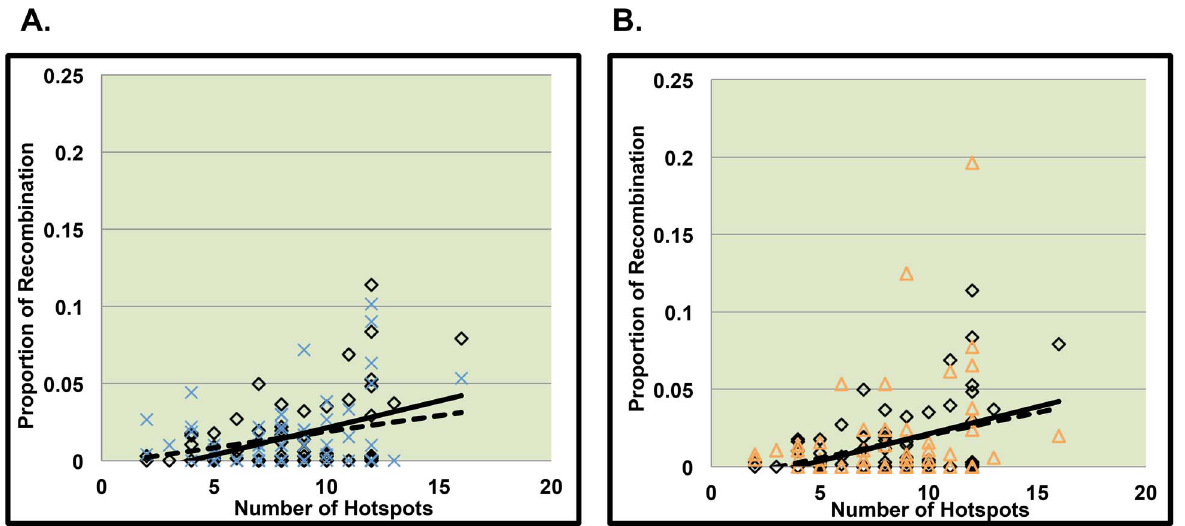
Figure 6. Comparison of slopes between MI or MII errors and controls for the distal recombinant of double recombinant events. Figures 6A and 6B represent data from the distal recombinant event of chromosomes displaying two recombinant events on 21q. The solid line represents the relationship between the number of hotspots per bin and the proportion of recombination per bin along normally segregating chromosomes 21. The dotted line represents the relationship between the number of hotspots per bin and the proportion of recombination per bin along chromosomes 21 from MI errors (figure 6A) and MII errors (figure 6B).